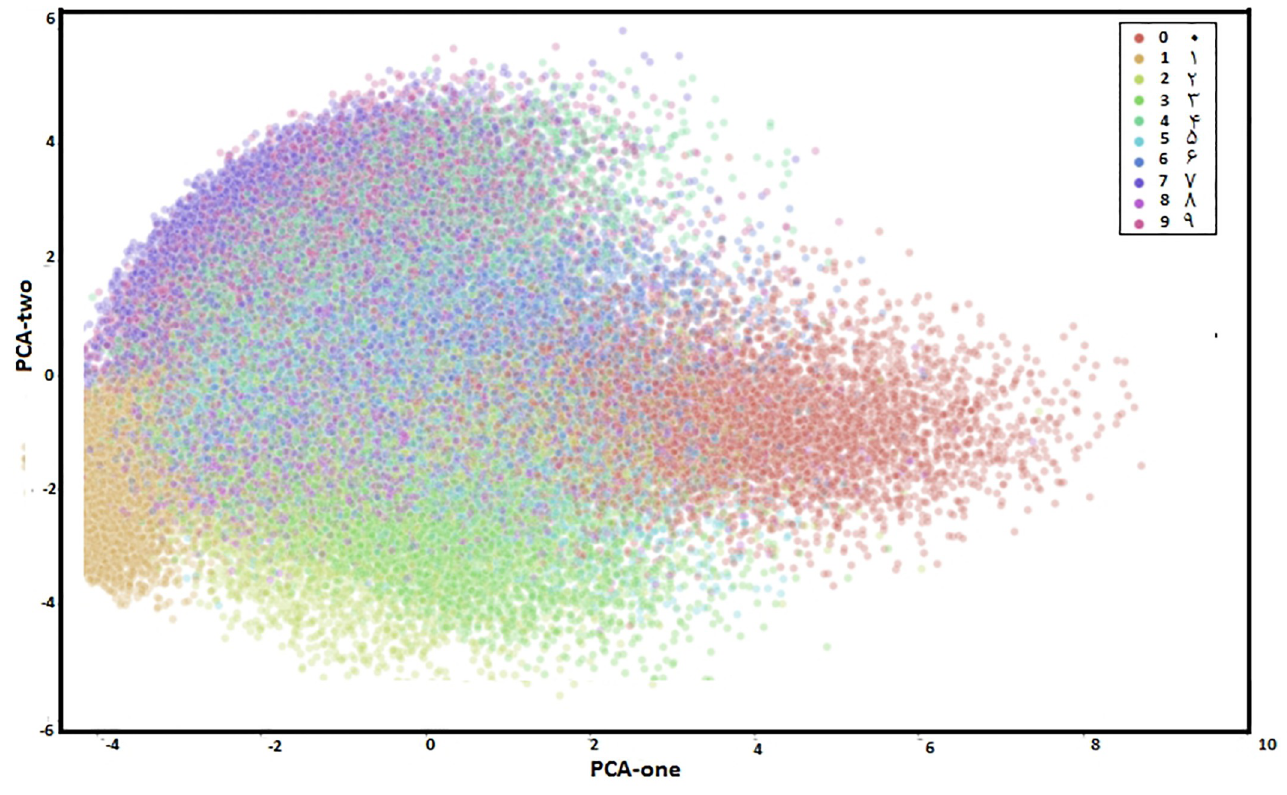
Fig 5. 2D visualization of the distribution of data through